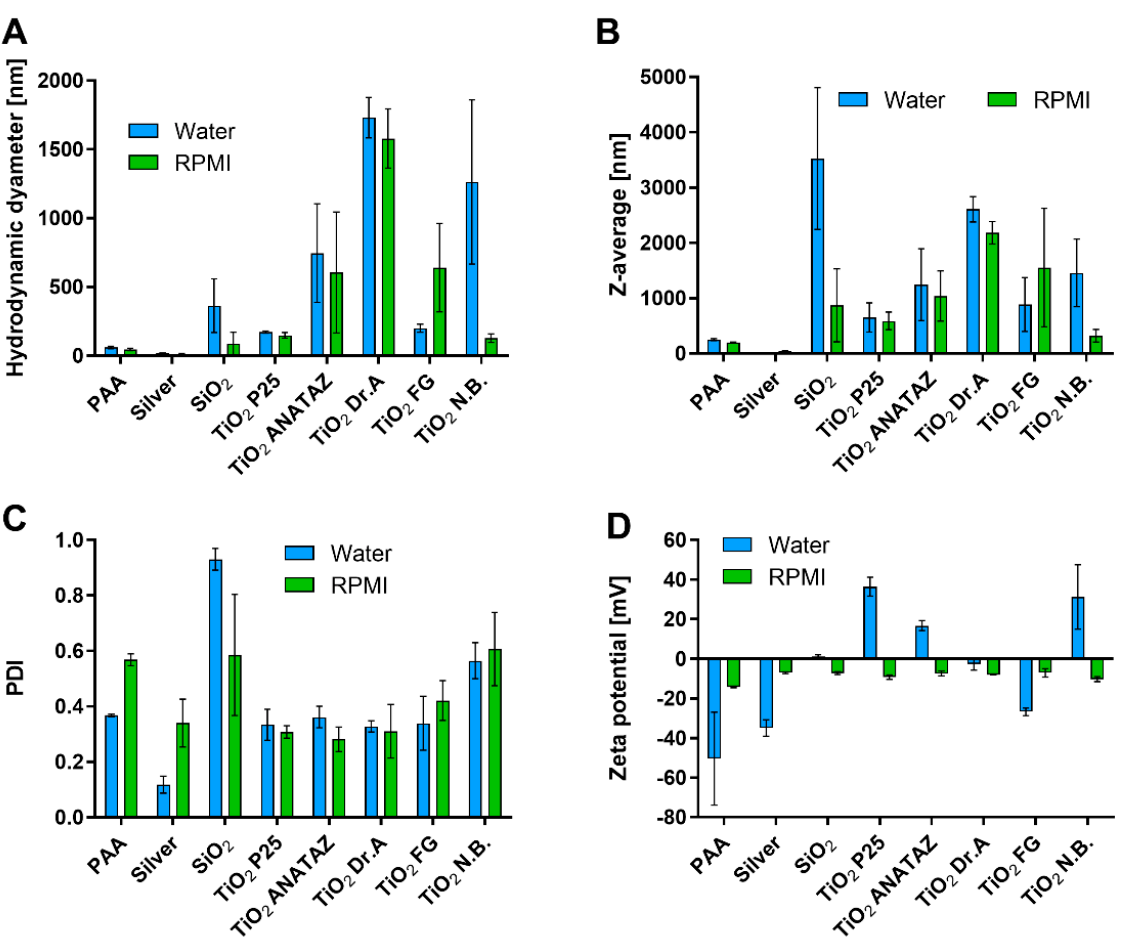
Figure 1. Analysis of physico-chemical properties of NPs. ( A ) Hydrodynamic diameter based on the particle number distribution; ( B ) Z-average size based on the intensity distribution and ( C ) polydispersity index (PDI) of the number distribution measured with DLS; ( D ) Zeta potential in water and RPMI media with 10% FBS ( m / v ). Mean values with standard error of the mean from three independent measurements are shown.